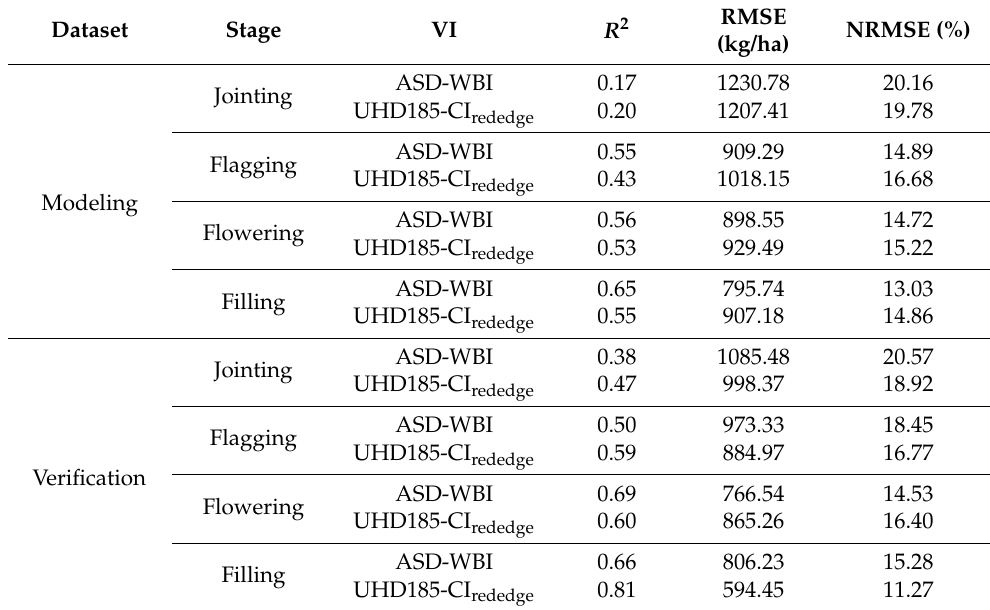
Table 4. The relationships between the yield and the optimal VIs at different growth stages.